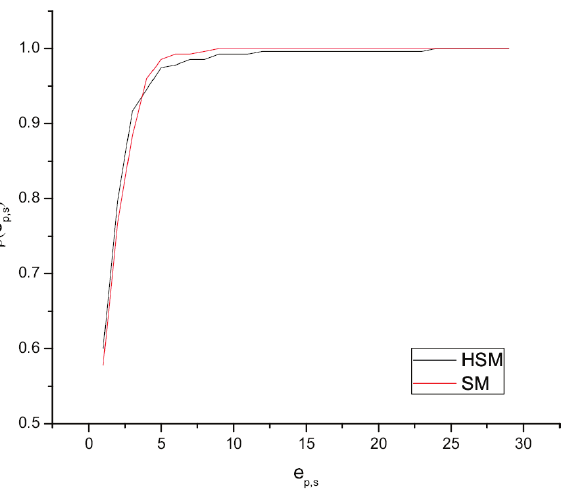
Figure 3. Performance profiles for the HSM and SM methods regarding the number of function evaluations